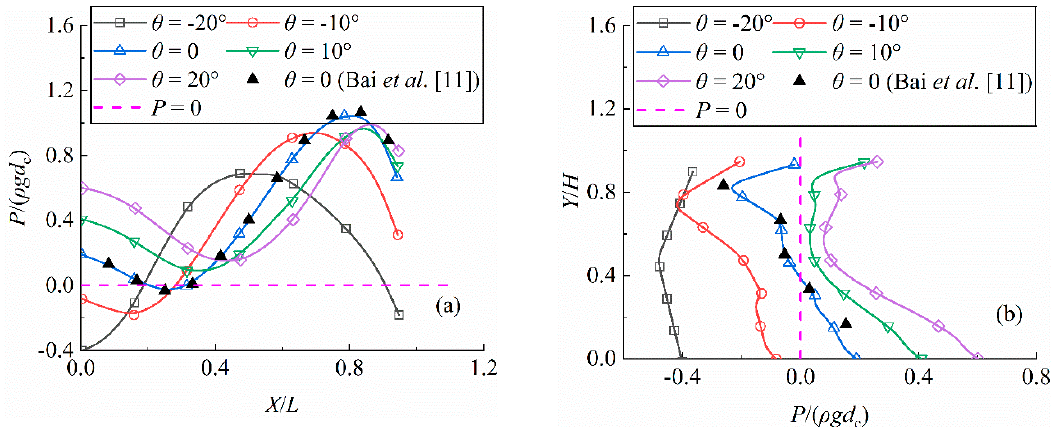
Figure 6. Flow pressure distribution along step surfaces at step no. 43 (dc / h = 4.8): ( a ) horizontal and ( b ) vertical.